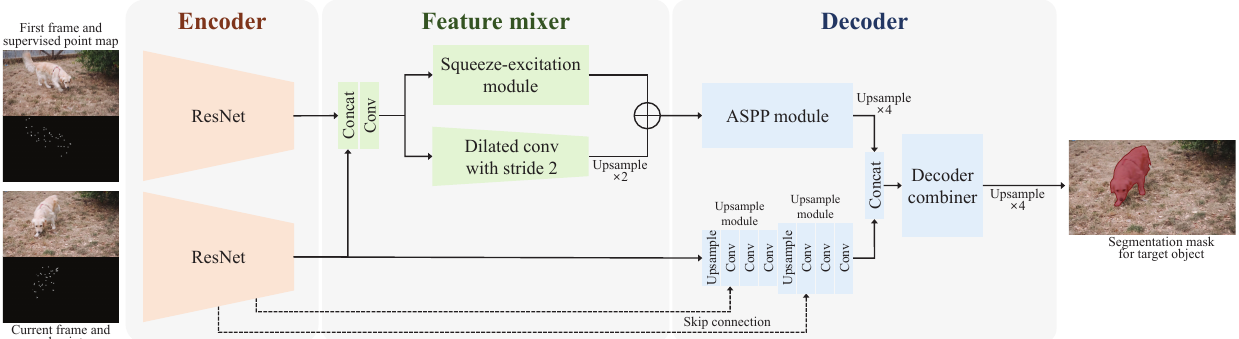
Figure 6. The architecture of the proposed